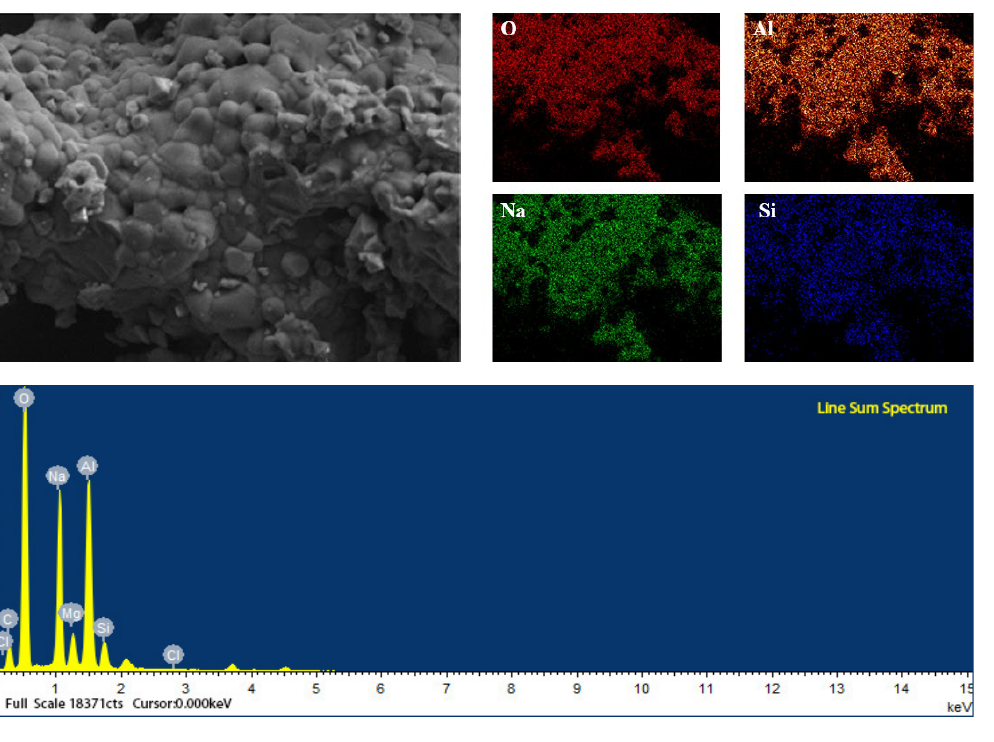
Figure 8. SEM-EDS image of the roasted sample with sodium carbonate added at m sodium carbonate : m alumi- Figure num dross = 0.6, roasting temperature = 1000 °C, roasting time = 3 h.